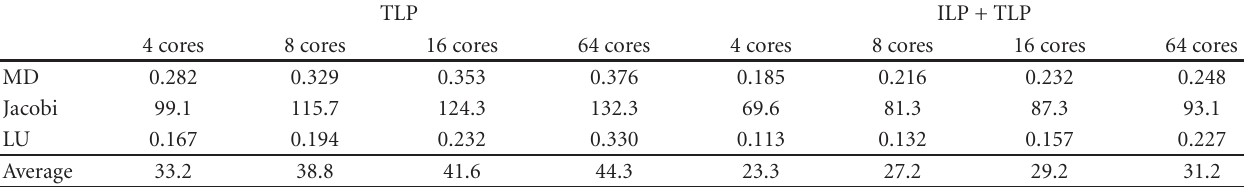
Table 4: Energy consumption, in mJ, of both multiprocessing system and reconfigurable system on running MD, Jacobi and